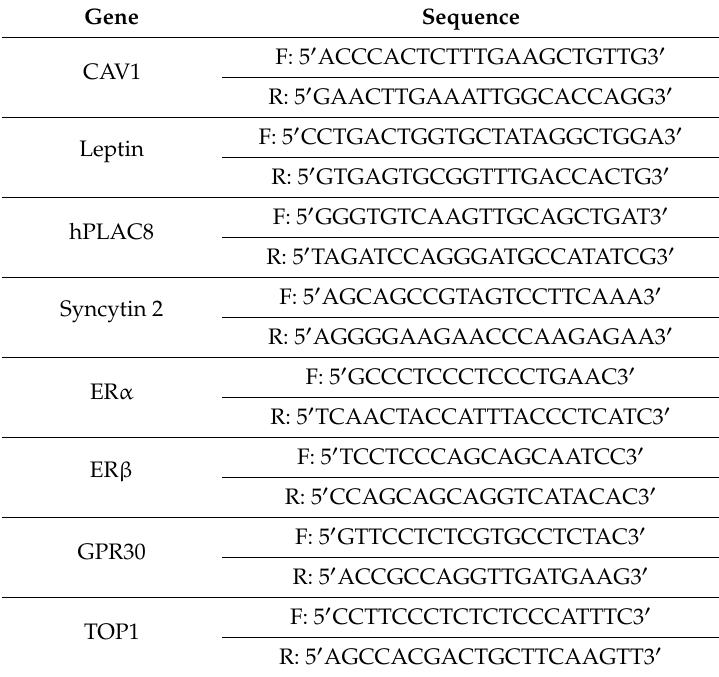
Table 1. List of primers used for